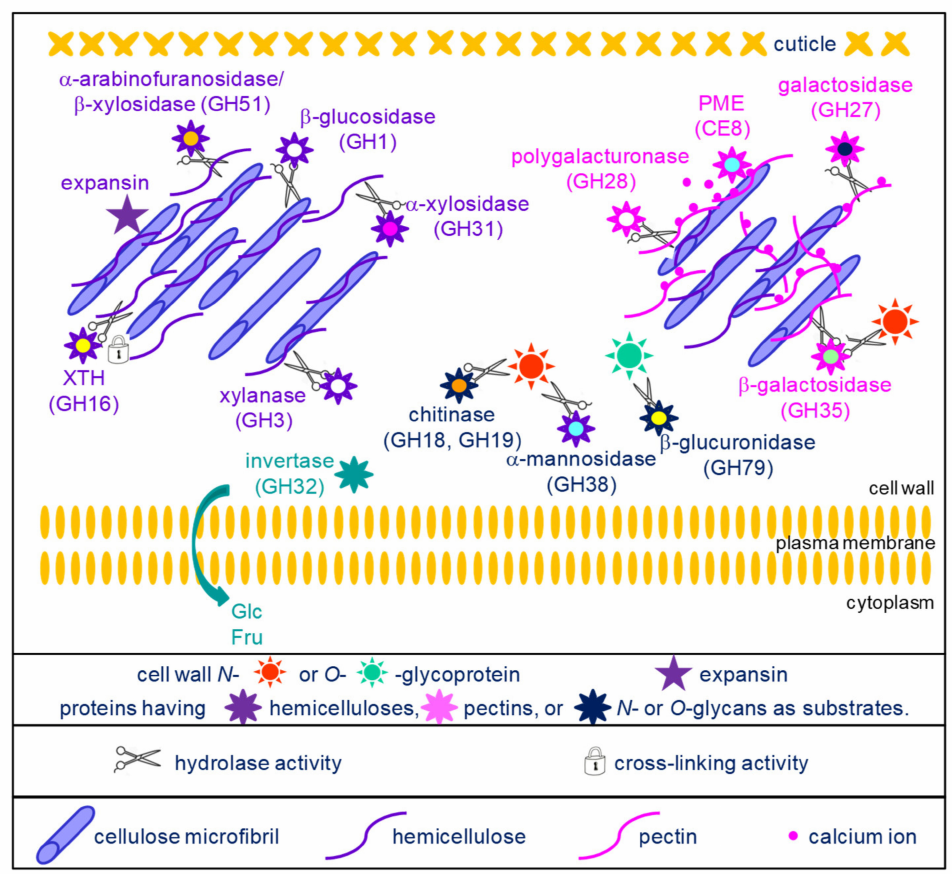
Figure 2. Schematic representation of the activities of the proteins acting on cell wall carbohydrates and belonging to the core cell wall proteome. With the exception of expansins and CE8, all the protein families are glycoside hydrolases (GHs) which were grouped according to their possible substrates (Section 4.1 for details): cellulose and hemicelluloses for GH1, GH3, GH16, GH31, GH51 and expansins (top left part of the scheme); pectins for GH27, GH28, GH35 and CE8 (top right part of the scheme); N - or O -glycans for GH18, GH19, GH38 and GH79 (center of the scheme); sucrose for GH32, thus releasing glucose (Glc) and fructose (Fru) which can be transferred to the cytoplasm by hexose